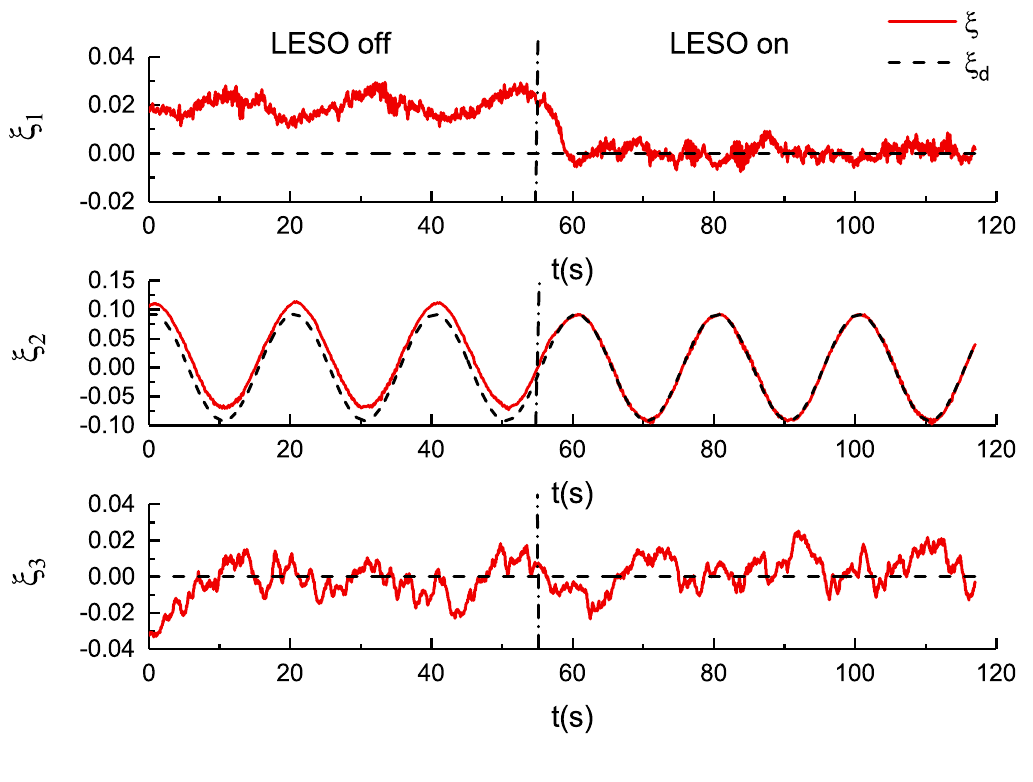
Figure 8. Attitude-tracking effect with the LESO off and on.